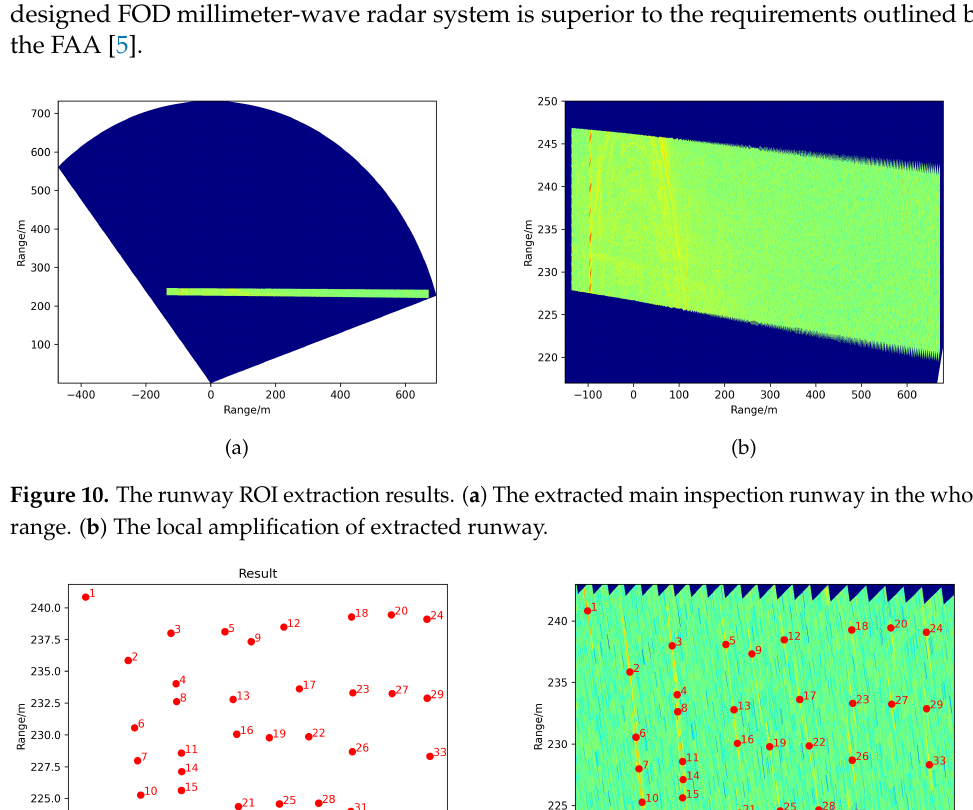
Figure 9. The establishment of background clutter map in 3D view.